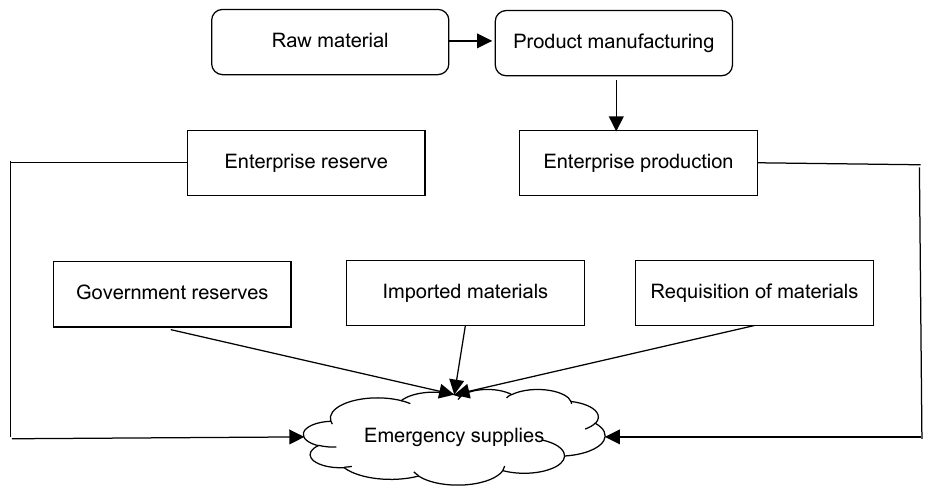
Fig. 1 Border map of the peacetime and wartime material supervision system.